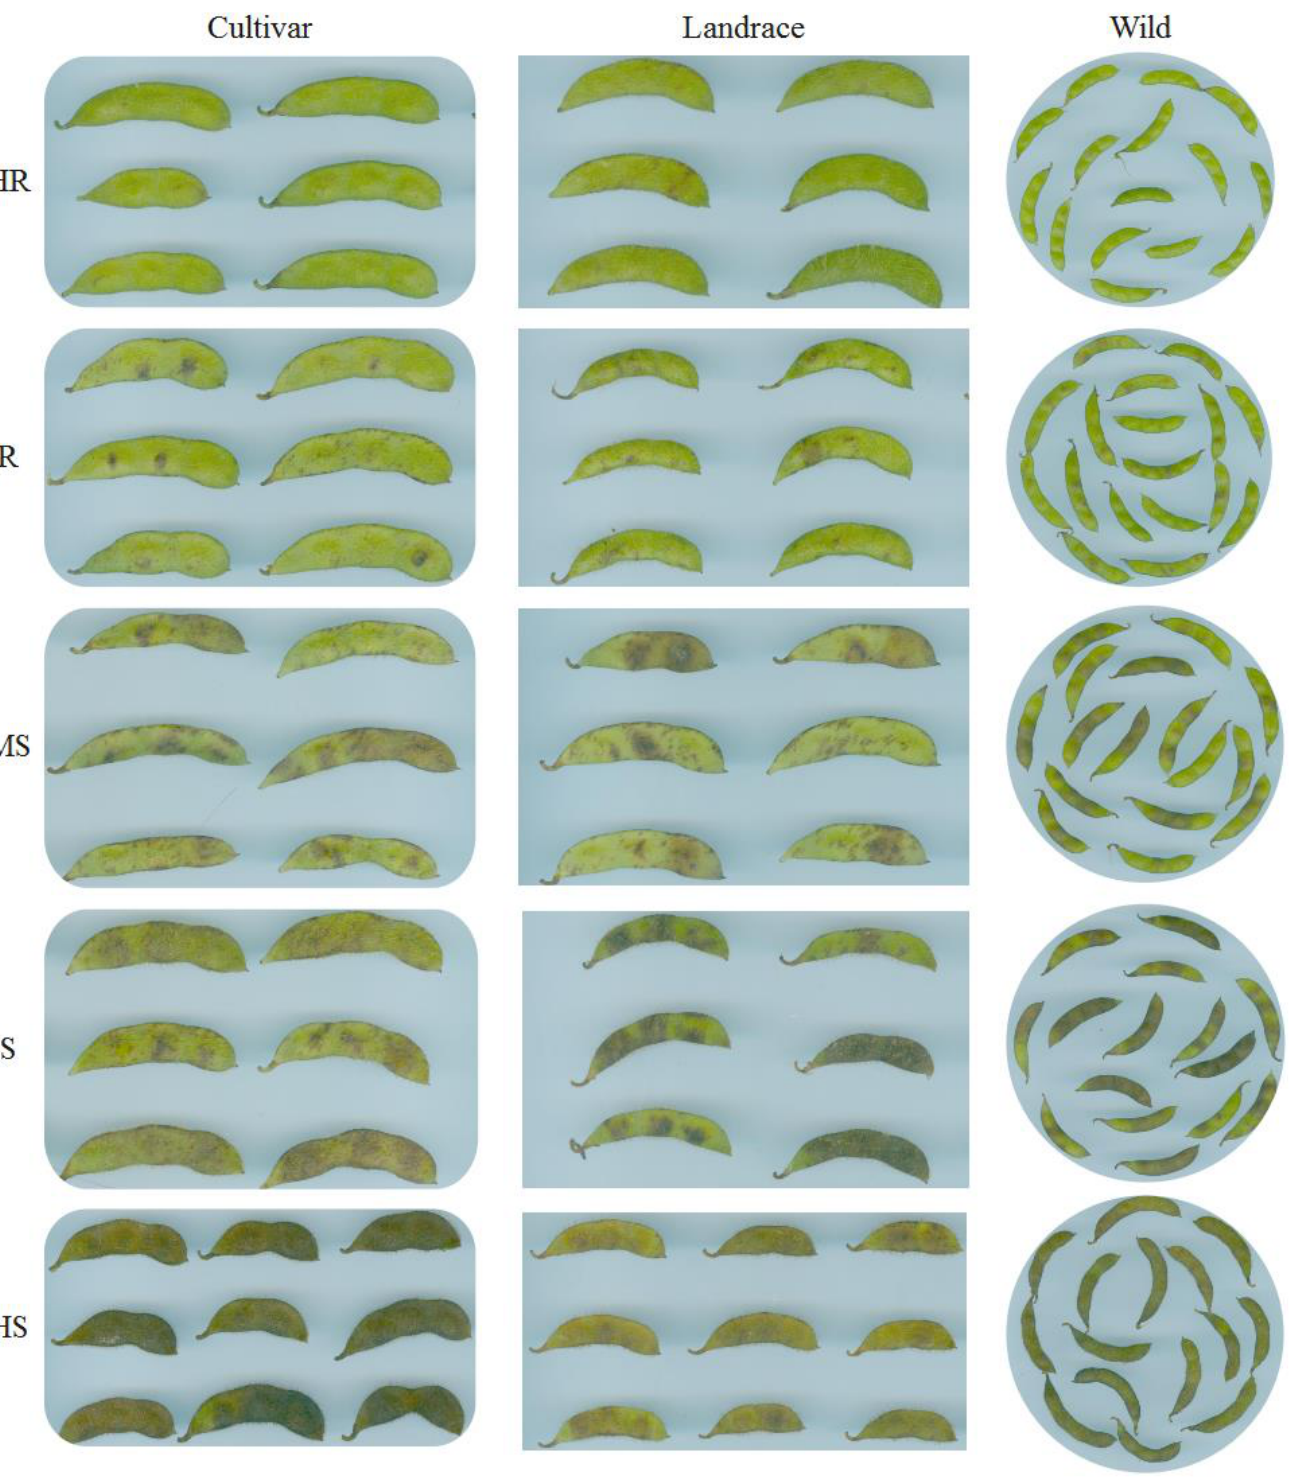
Figure 7. Representative symptoms for each resistance level and each germplasm resource type. HR, highly resistant; R, resistant; MS, moderately susceptible; S, susceptible; HS, highly susceptible.